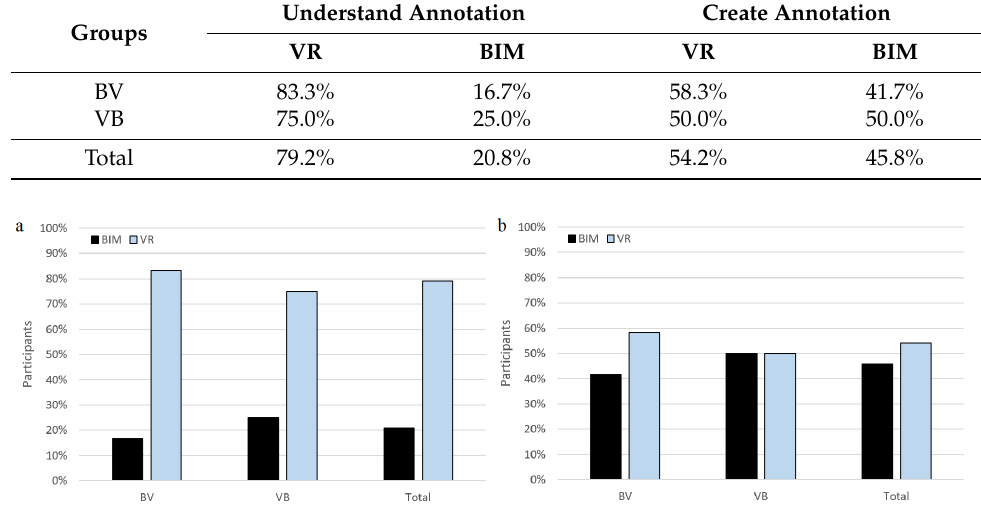
Figure 8. Participants’ platform preferences to: ( a ) understand annotations; ( b ) create